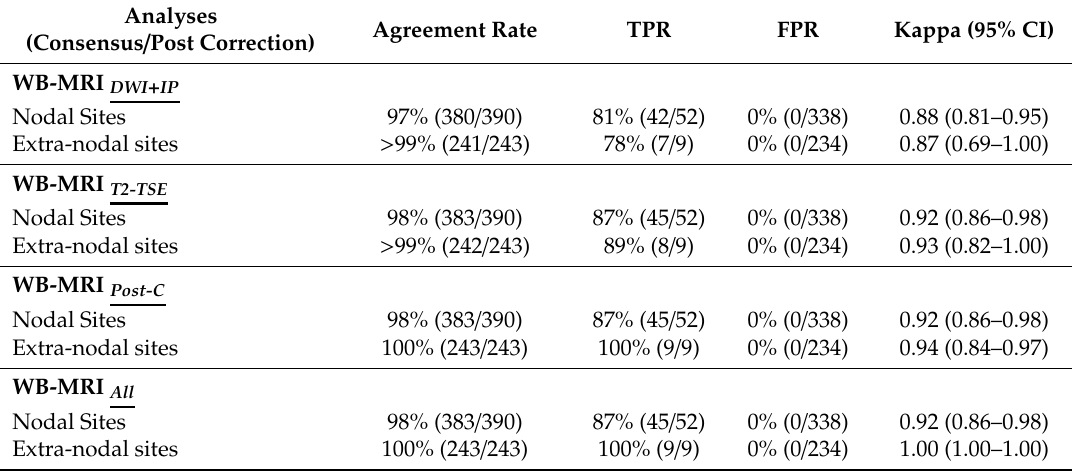
Table 6. Comparison of di ff erent MRI sequences as part of the WB-MRI protocol for nodal and extra-nodal disease evaluation for the consensus read following correction of the anatomical boundaries discrepancies and WB-MRI perceptual